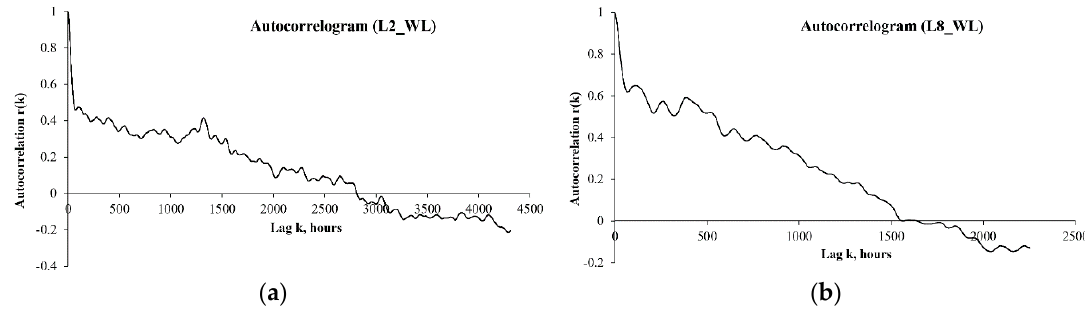
Figure 14. ( a ) Autocorrelogram for L2_WL data; ( b ) autocorrelogram for L8_WL data.